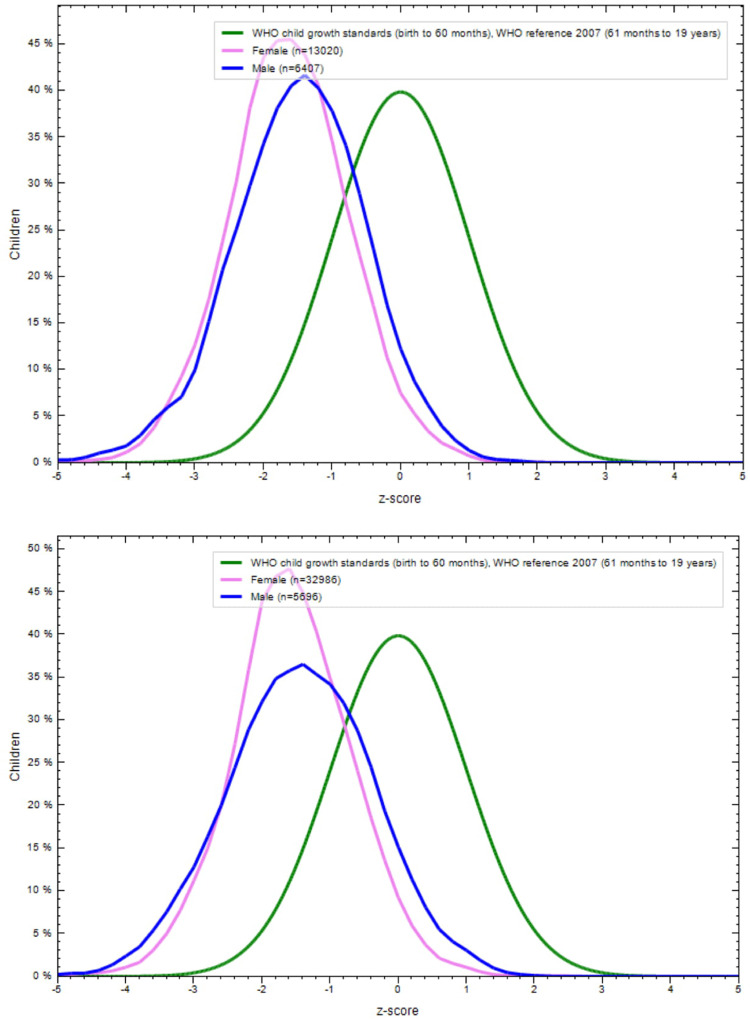
A. Height-for-age z-score of rural adolescents (15–19 years) in NFHS-4 (2015–16). B. Height-for-age z-score of urban adolescents (15–19 years) in NFHS-4 (2015–16).